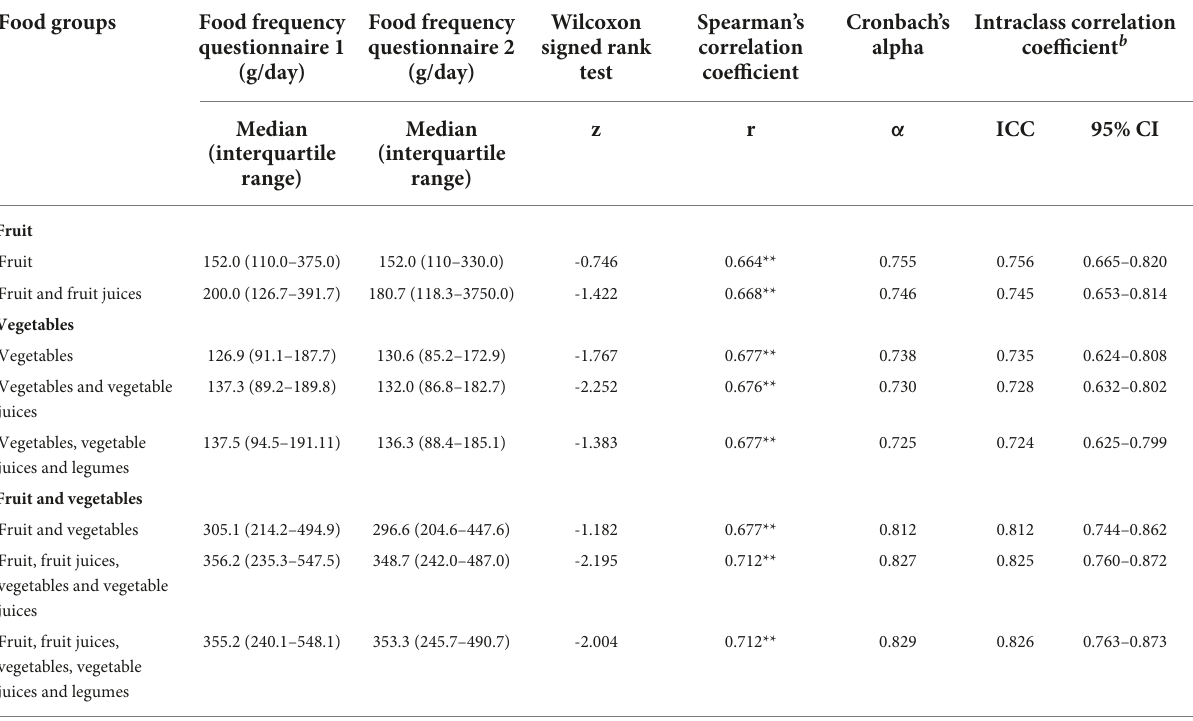
TABLE 3 Reproducibility and median values for food frequency questionnaires for the fruit and vegetable consumption in school-aged children ( N = 161). a Food